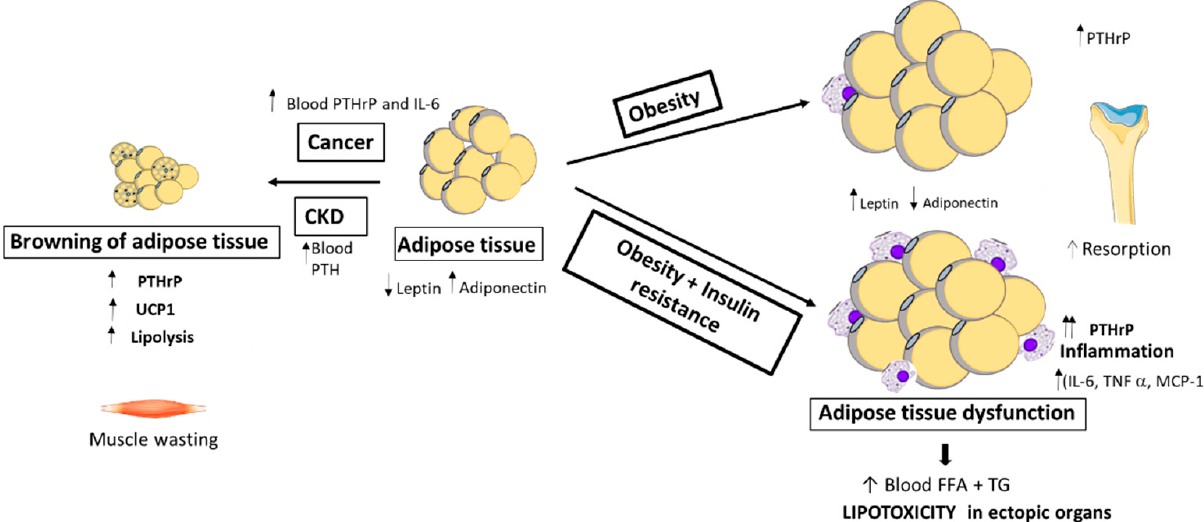
Figure 2. PTHrP and adipose tissue. CKD: Chronic kidney disease; FFA: Free fatty acids; IL-6: Interleukin 6; MCP-1: Monocyte Chemotactic Protein 1; PTHrP: Parathyroid hormone-related protein; TG: Triglycerides; TNF α : Tumor necrosis factor-alpha; UCP-1: Uncoupling protein 1.